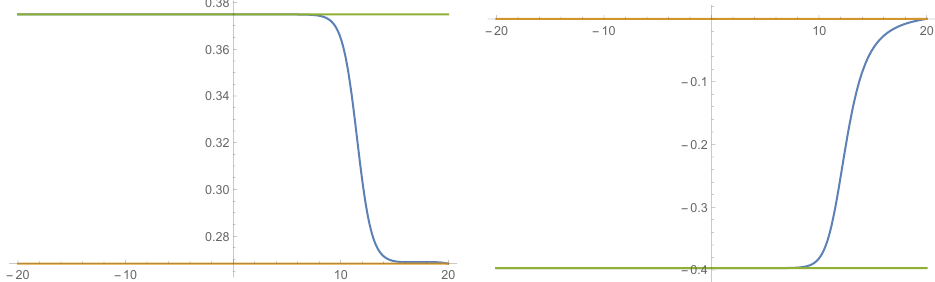
(cid:96) . The scalar vevs asymptote to